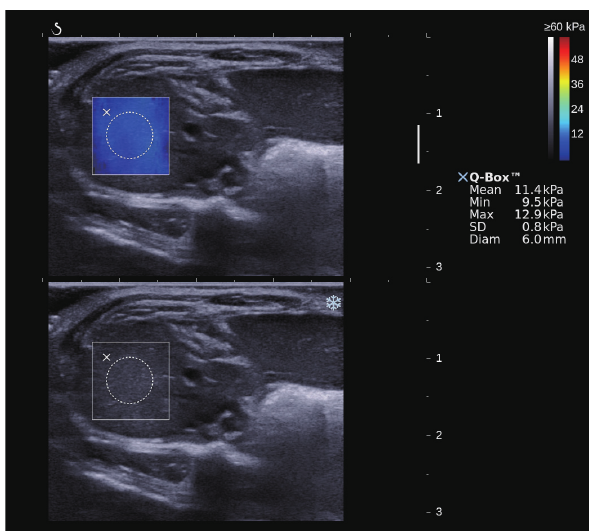
Figure 1 Examples of shear wave elastography (SWE) measurements of rat liver. (Bottom) Conventional gray scale ultrasound images of the liver without visible ducts. (Top) Images of SWE: the color-coded areas are the sample areas (1 cm × 1 cm), and the circular frames are Q-BOX, which represent the quantitative measurement region. The mean elasticity value is 11.4 kPa, histologically proven to be fibrosis stage 4.